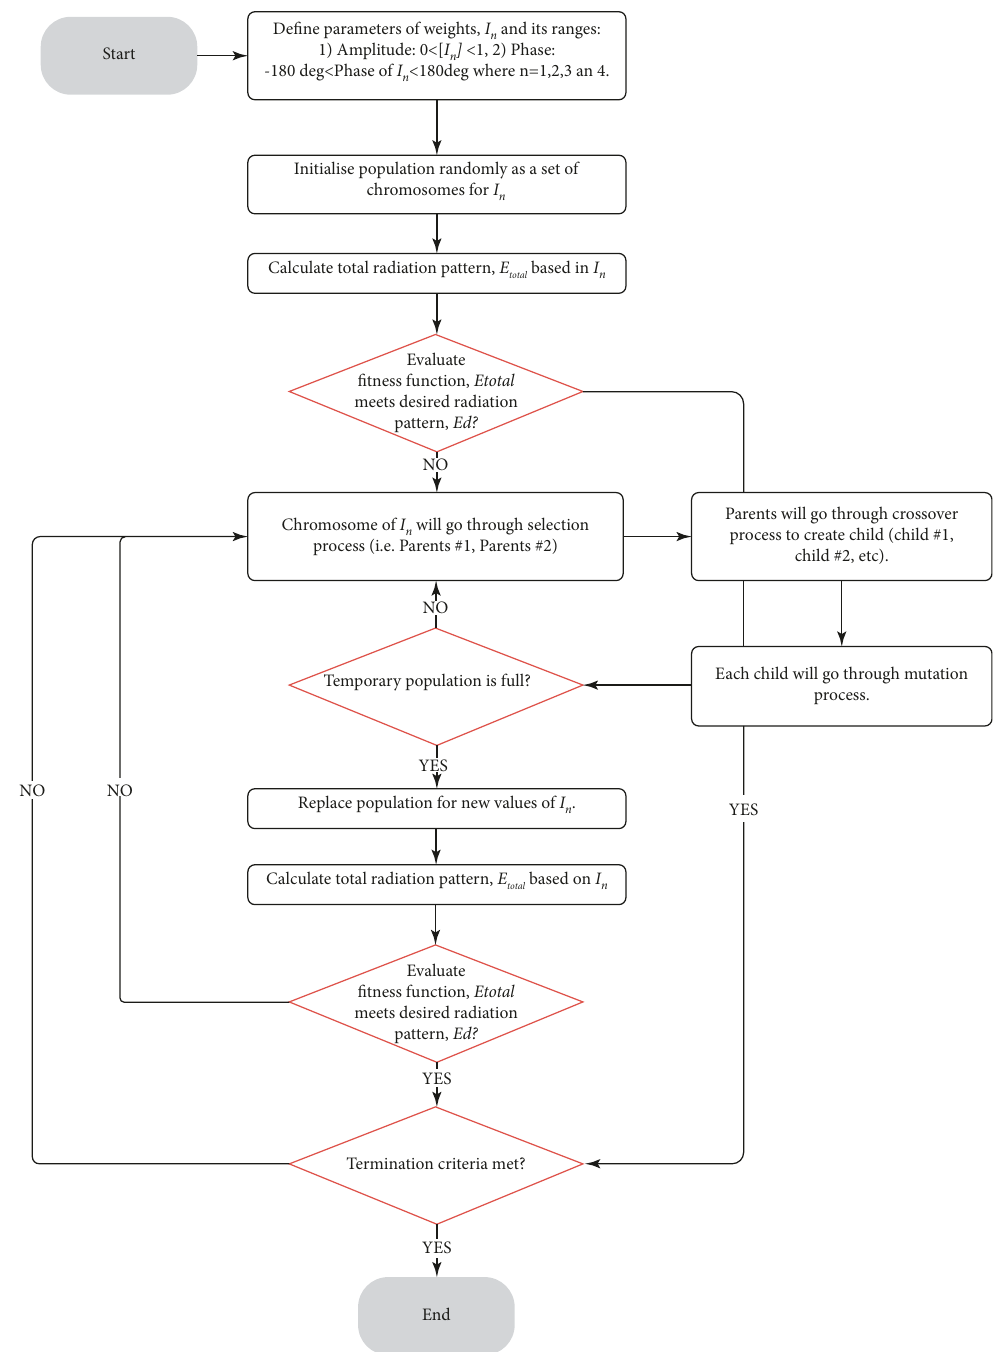
Figure 4: Flowchart of hybrid GA and the induced EMF